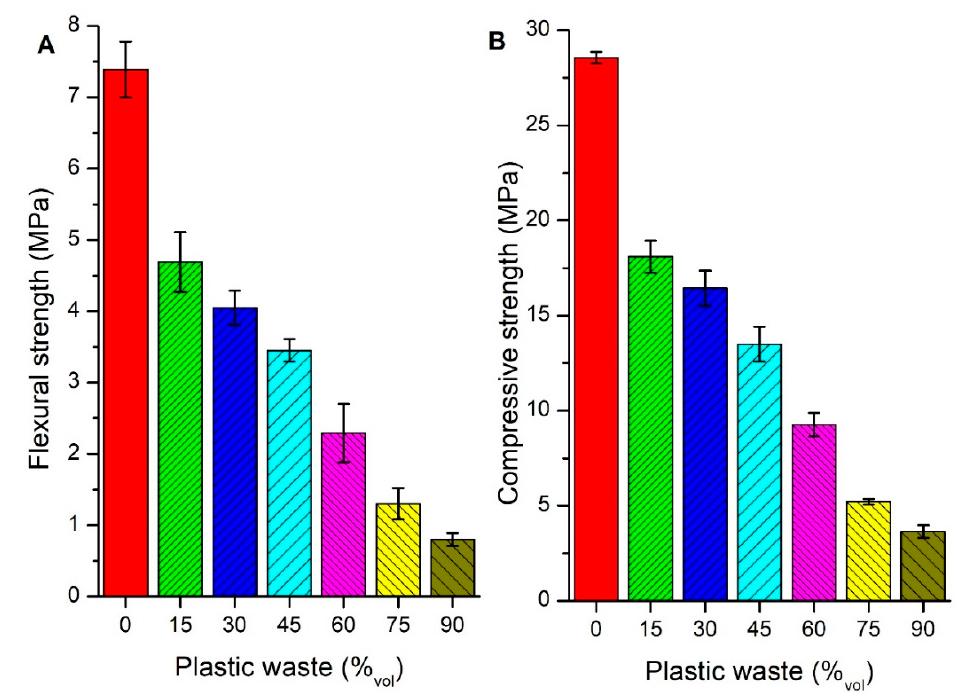
Figure 1. Mechanical properties of plastic-substituted mortar as a function of the percentage of sand substituted with waste plastics: ( A ) flexural strength, ( B ) compressive strength.